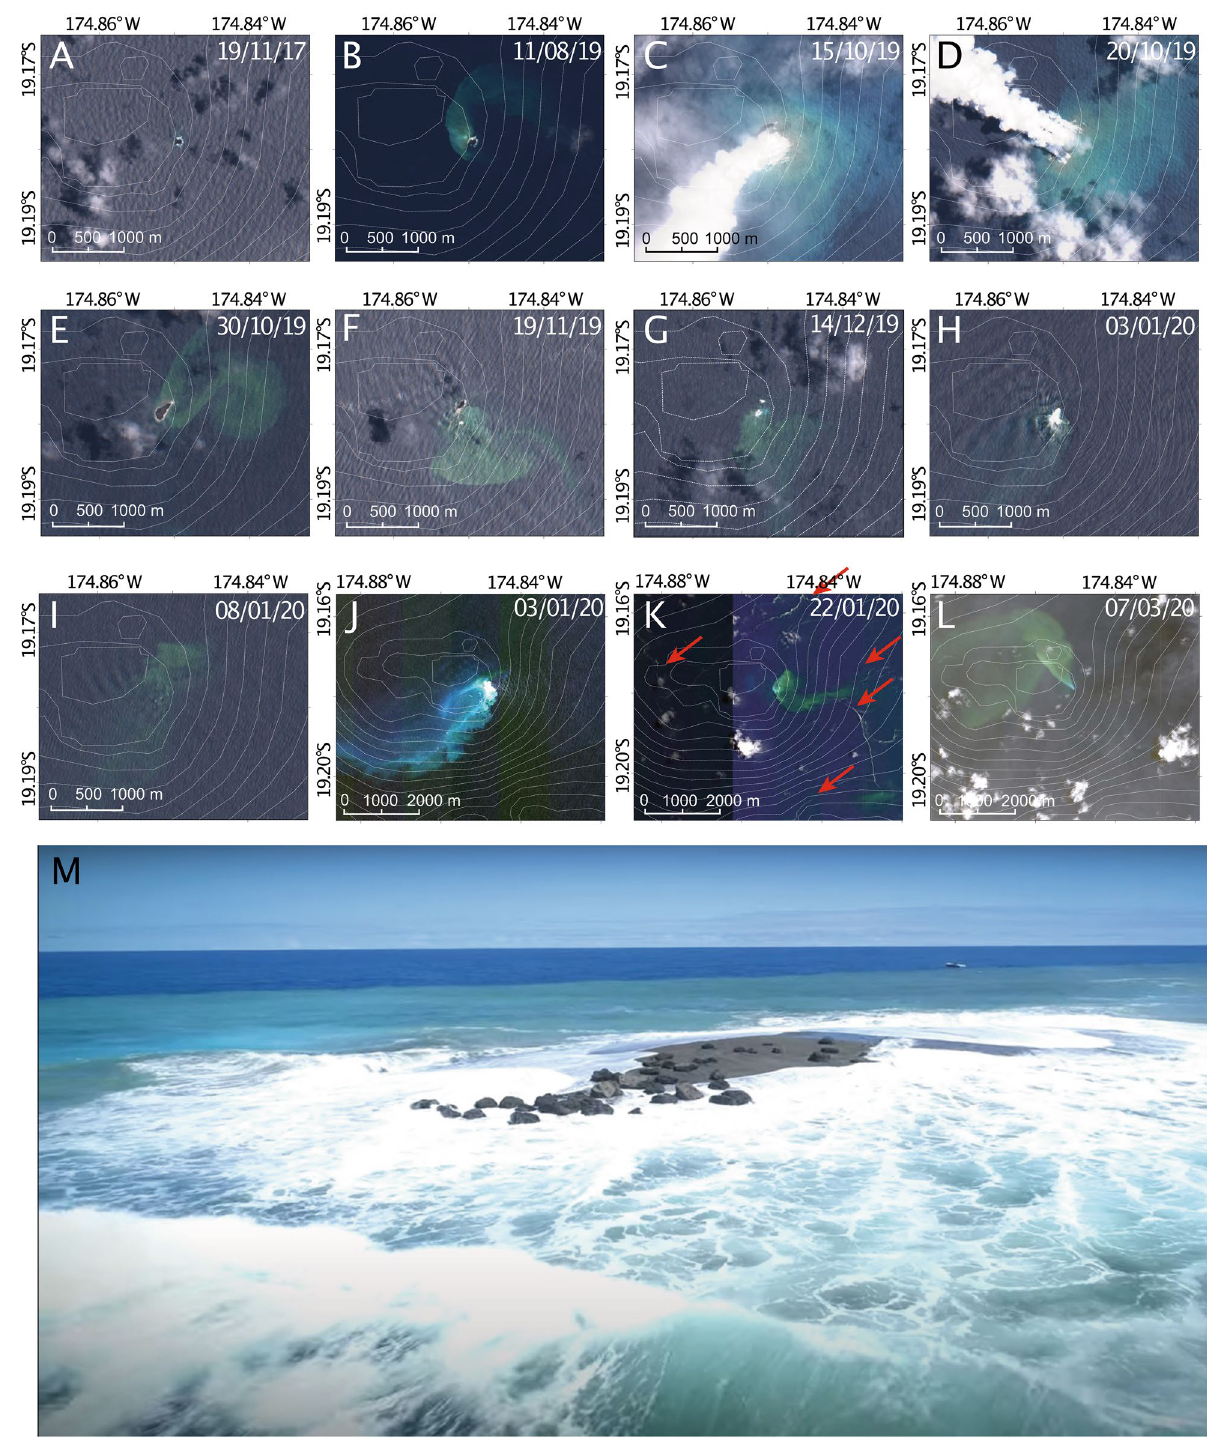
Figure 2. Satellite imagery of the 2019–2020 eruption phases. ( A – I ) Sentinel imagery 59 showing the same region before, during and after the October 2019 eruption. Superimposed 100 m contours are from the GMRT grid 60 but are not very accurate in this area and are for orientation only. ( J – L ) MAXAR WorldView-2 and WorldView-3 satellite data of the region showing key events 53 . Contours are the same as in panels ( A – I ) but the maps are shown at a different scale. Red arrows in panel K show floating material in the water surrounding the volcano. ( M ) Drone view of the remains of New Late’iki island on December 3 (taken by Darren Rice of Matafonua Lodge). The island has been reduced to sea level, being continually wave swept and comprises outsized metre-sized blocks of dacitic lava resting on lapilli to ash sized fragmented lava material generated by phreatic explosions. The island is surrounded by an extensive hydrothermal